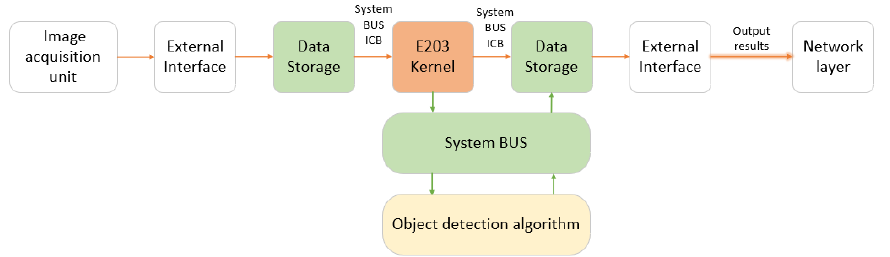
Figure 2. Data flow of the accelerator for object detection.